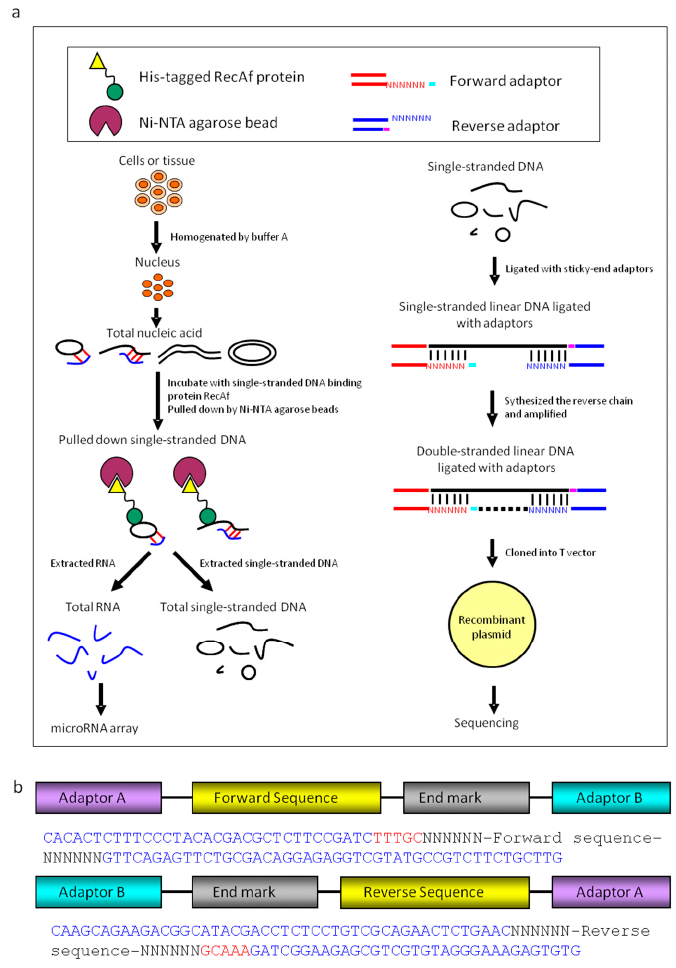
Figure 1. Preparation of extrachromosomal single-stranded linear microDNAs and microRNAs. ( a ) The single-stranded linear DNAs were pulled down by the RecA f protein. RNAs and single-stranded linear (SSL) DNAs were isolated through pulldown system based on RecA f protein. microRNA array analysis was performed with the RNA samples. Following ligation with two adaptors, the single-stranded linear DNAs libraries were constructed and sequenced. ( b ) The composition of adaptor A and adaptor B. Adaptors composed of end markers and random bases. N represents a random base. TTTGC and GCAAA were end markers in adaptor A or B.